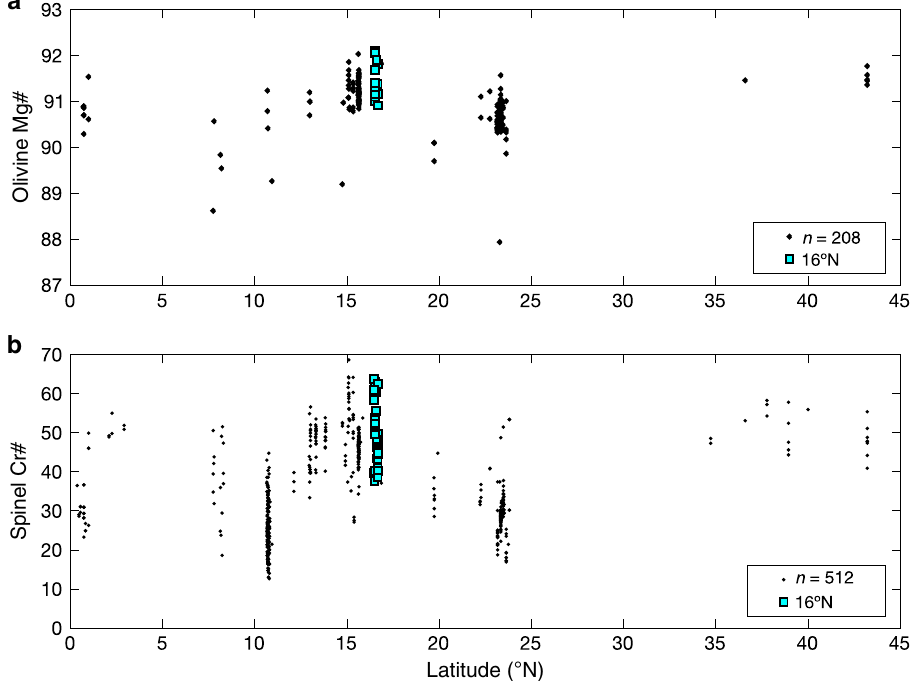
Fig. 2 Mid-Atlantic Ridge latitudinal variations in peridotite composition. a Olivine Mg# (molar Mg/(Mg + Fe 2 + )) along the Mid-Atlantic Ridge shows the anomalously refractory compositions present at the 14 – 17°N region. Additional data from 15°20 ′ N FZ in Supplementary Data 4, previously unpublished. b Peridotite spinel Cr# (molar Cr/(Cr + Al)) extend to very high values (>55) between 14° and 17°N, atypical of anhydrous melting at mid-ocean ridge settings. Black data points for both plots from the literature 23,42,71 . Analytical uncertainties smaller than